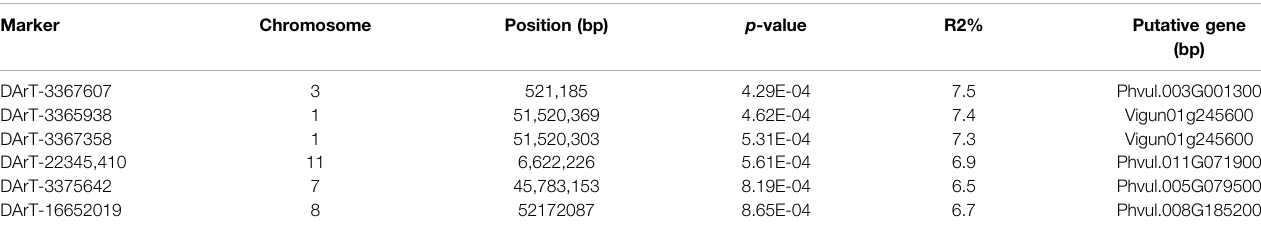
TABLE 4 | Chromosomal regions associated with seed Mg contents in Turkish common bean germplasm.